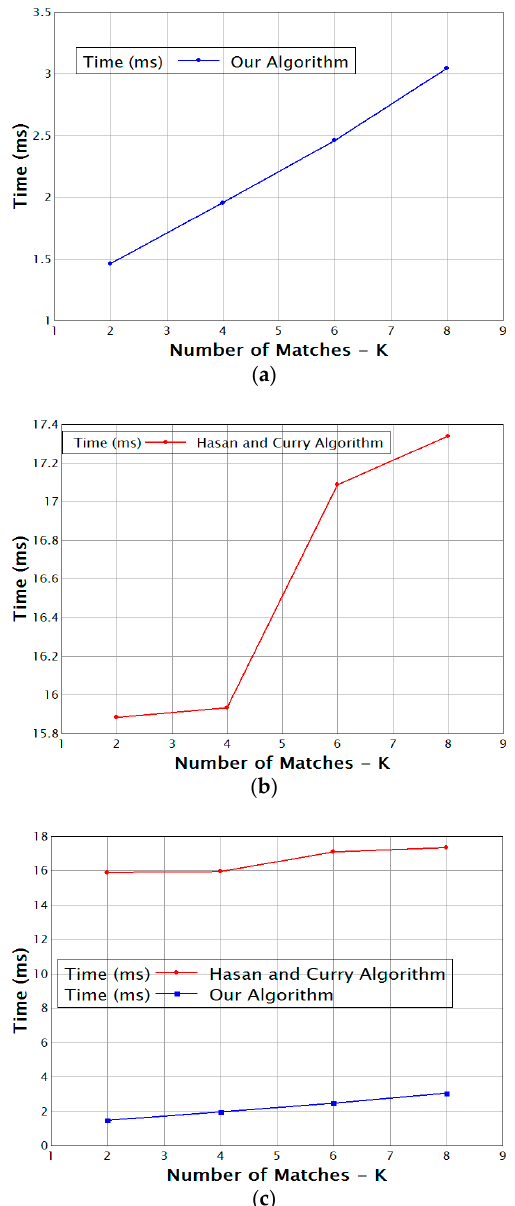
Figure 4. K vs. time ( a ) for our algorithm and ( b ) for the algorithm of Hasan and Curry; ( c ) Comparison of the two methods.